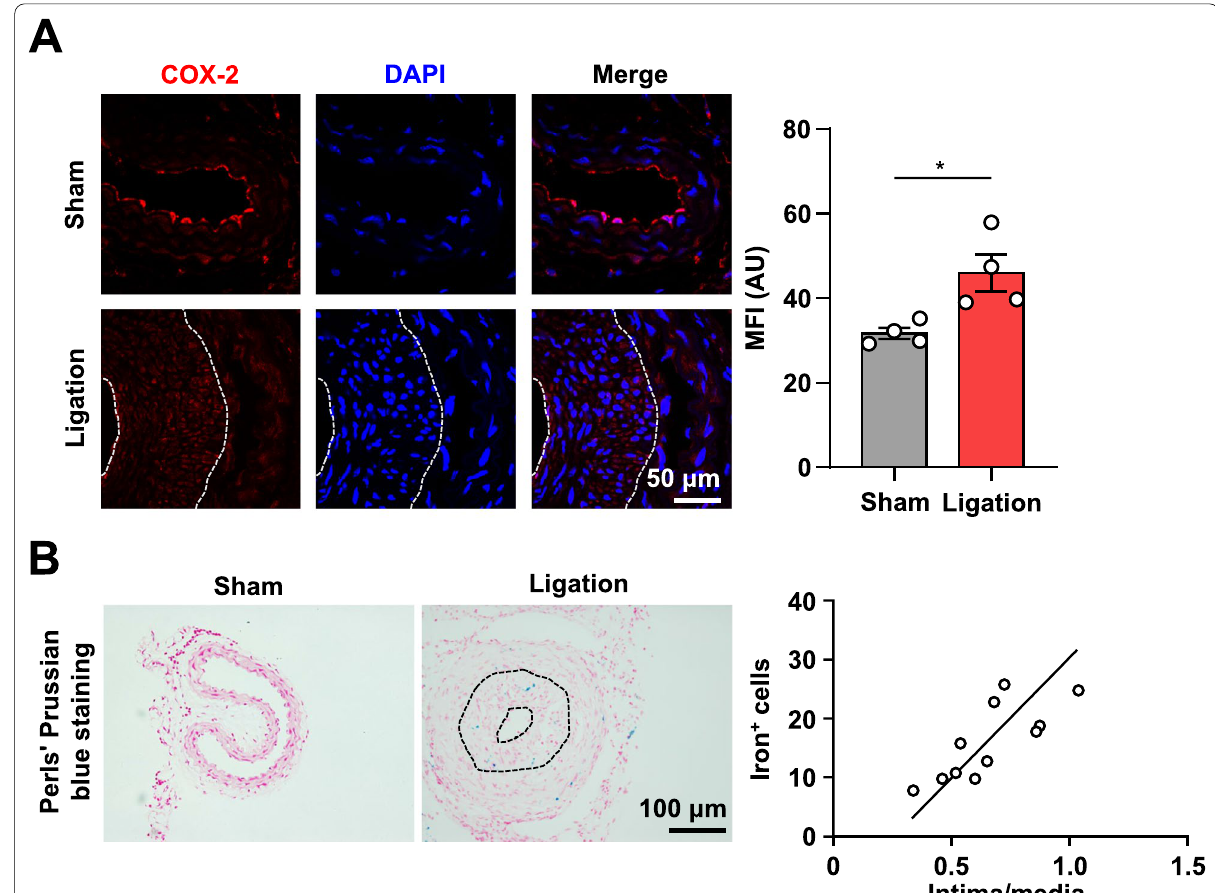
Fig. 1 Ferroptosis is positively associated with neointima formation. A The presentative images and quantification of COX‑2 mean fluorescence intensity (MFI) in mouse carotid artery after 4 weeks of ligation or not ( n carotid artery after 4 weeks of ligation. The correlation of intima/media and iron + cells in neointimal formation ( n bar, 100 μm. Data are presented as mean